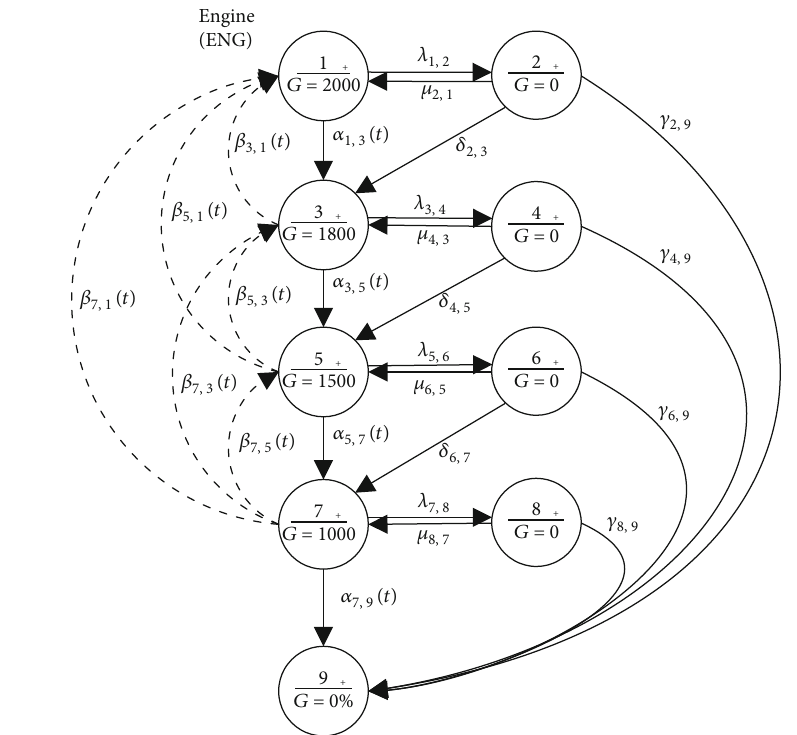
Figure 3: State-transition diagram of